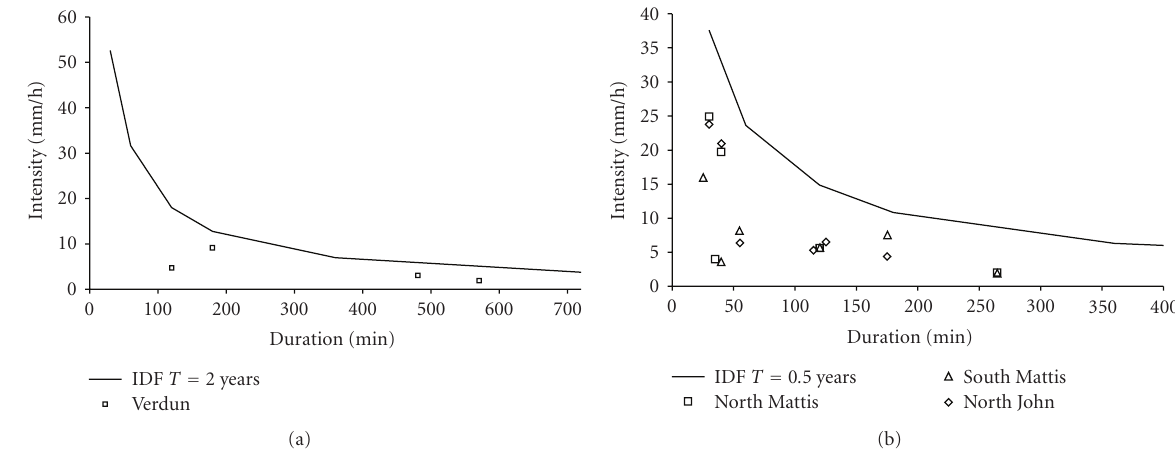
Figure 4: Intensity Duration Frequency (IDF) of rainfall events monitored in (a), Verdun borough catchment and (b), North Mattis, South Mattis, and North John catchments.